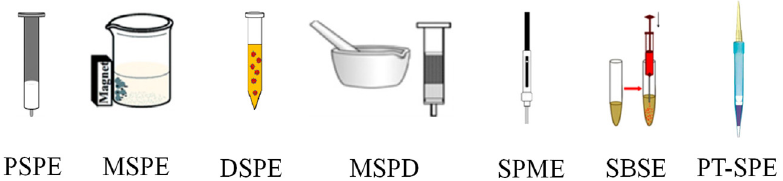
Figure 2. Schematic illustration of the different modes of SPE. Adapted from Ref.